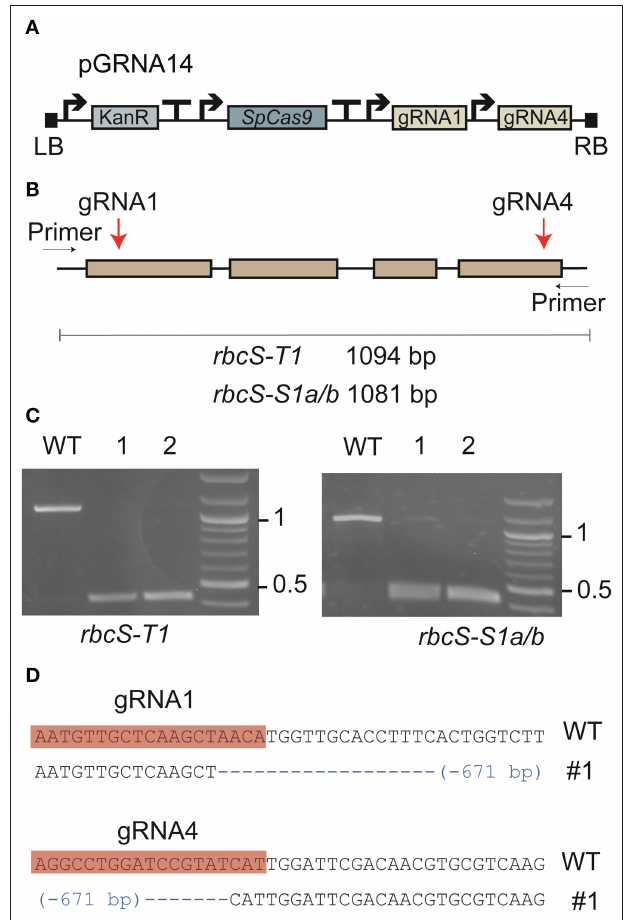
FIGURE 1 | Expression of a Cas9-gRNA vector targeting three Rubisco small subunit genes in tobacco. (A) Cas9-gRNA expression construct with Cas9 from Streptococcus pyogenes (SpCas9) and two gRNA sequences (gRNA1 and gRNA4) (see Supplementary Figure 1 for details of vector pGRNA14). (B) The target sites of gRNA1 and gRNA4 were located on the first and fourth exons, respectively, in rbcS-T1 , rbcS-S1a , and rbcS-S1b . (C) PCR screen of leaf tissue with pGRNA14 transiently expressed showed deletion events (i.e., bands at < 500 bp) in rbcS-T1 (left) and rbcS-S1a/b (right). (D) Example of a pairwise sequence comparison of the deletion band from sample 1 (#1) for rbcS-T1 showed a 671 bp deletion between the gRNA1 and gRNA4 target sites compared to wild-type (WT) rbcS-T1